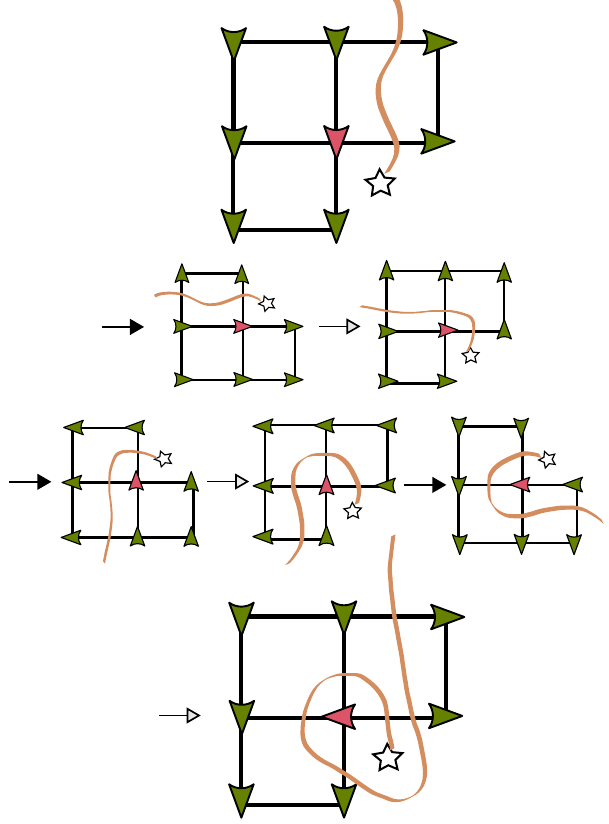
FIG. 5. An example of a C 4 disclination is shown undergoing a full rotation. Our Hilbert space is a product of C 4 spins on each site, and we depict the transformation of a particular basis element. The star indicates the missing quadrant of Sec. III A, across which spins (green) away from the rotation center (red) are glued by a 90-degree rotation (see also Appendix C). For convenience, we have used an orange domain wall to indicate the boundaries between regions of homogeneous spin (compare Fig. 6). The rotation itself is a two-step process which must be performed 3 times. The first step (black arrows) is to simply rotate the picture around the rotation center counterclockwise by 90 degrees. The second step (white arrows) is a gauge trans- formation (compare Fig. 7) that moves the missing quadrant to its original position. At the end of the process, all green spins have returned to their original configuration, while the spin at the rotation center has been rotated one unit. If there is a charge at the rotation center, the disclination thus picks up that charge as a phase after a full